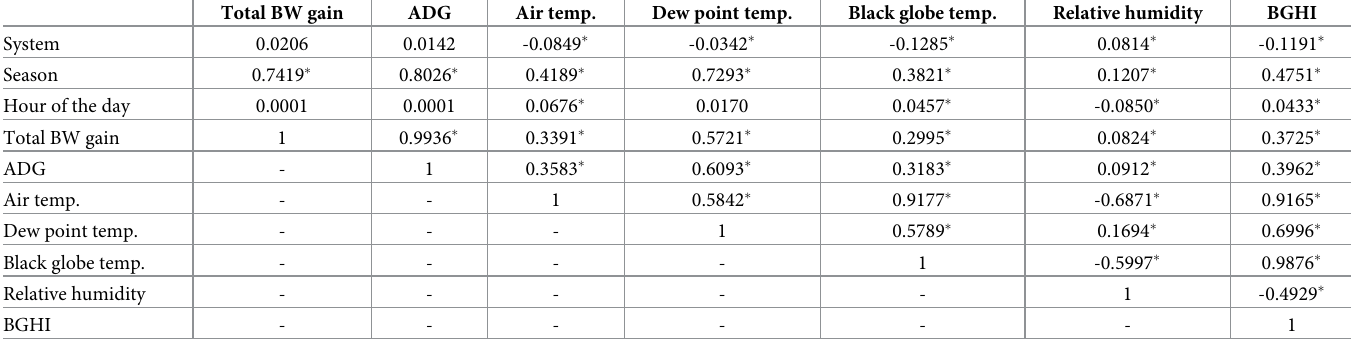
Table 2. Correlation matrix of the variables systems, seasons, hour of the day, performance of Nellore heifers, and climatic elements of systems with different microclimatic conditions.